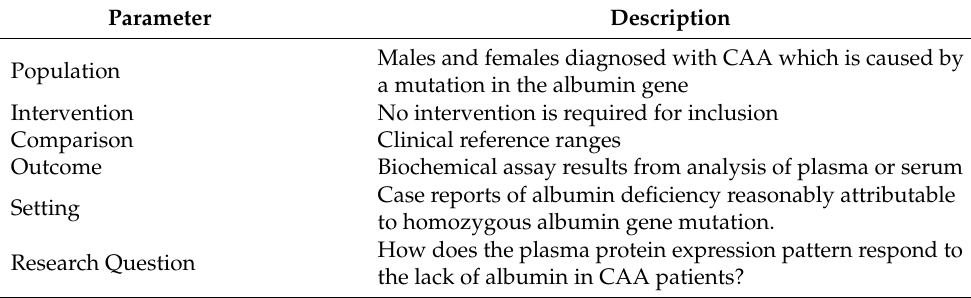
Table 1. PICOS . Table describing population, intervention, comparison, outcome, and setting for the systematic review. The research question is also